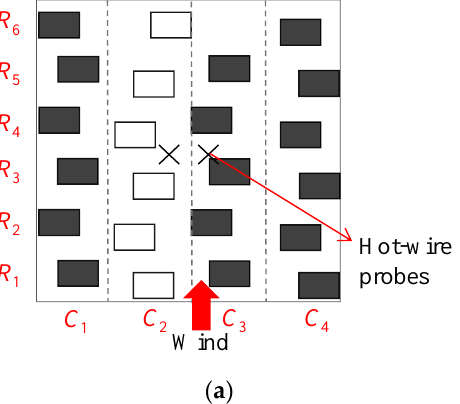
Figure 6. ( a ) Schematic diagram of wind tunnel platform. 1. Terrain roughness elements, 2. Pitot-static tube, 3. Floating device, 4. Pressure module, 5. Force sensor, 6. Pressure scanning valve system, 7. Force sensor system, 8. Hot-wire ane- mometers. ( b ) Actual setup in the wind tunnel.